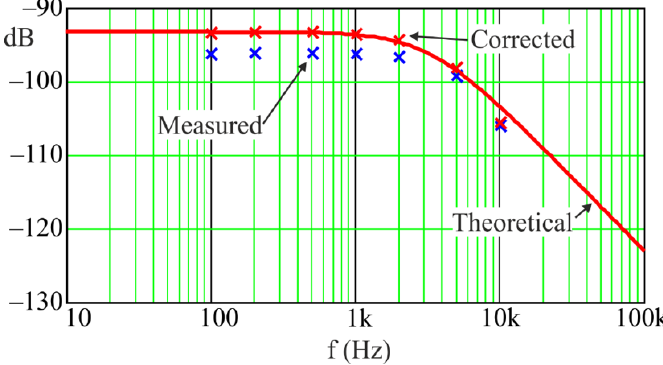
Figure 18. Theoretical and experimental LED current small-signal response against changes in the operating frequency.